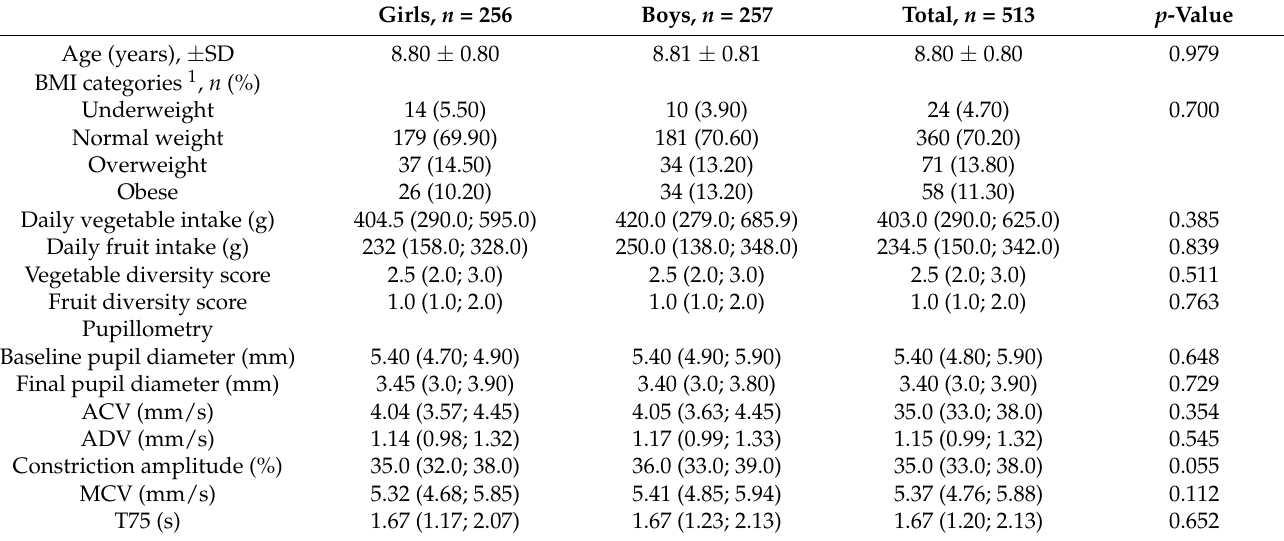
Table 1. Characteristics of the